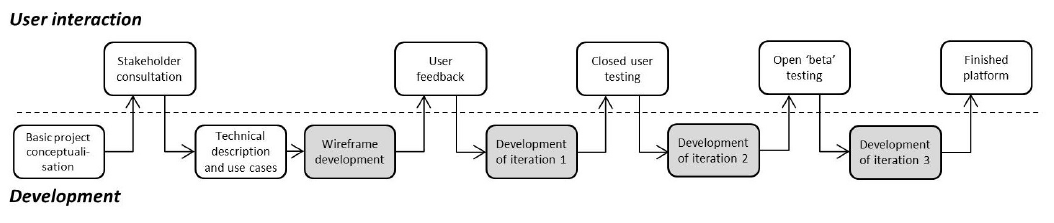
Figure 2. Simple flowchart of the development process of the MEDEA